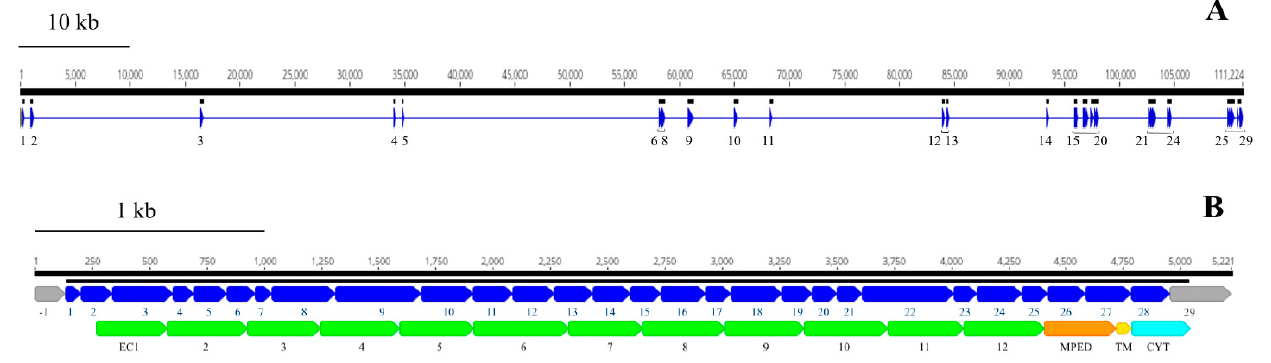
Figure 9. The Bt ‐ R1 ‐ like cadherin ‐ specific transcript abundance in the R. dominica larvae transcrip ‐ tomes (head, gut, and carcass). Sequence reads obtained after Ion Torrent sequencing were mapped to the open reading frame of the putative cadherin identified by similarity with several previously studied ʺ reference ʺ insect Bt toxin receptor cadherins. The mapped read counts were normalized by Reads Per Kilobase of template per Million mapped reads (RPKM,  SE, n = 3).